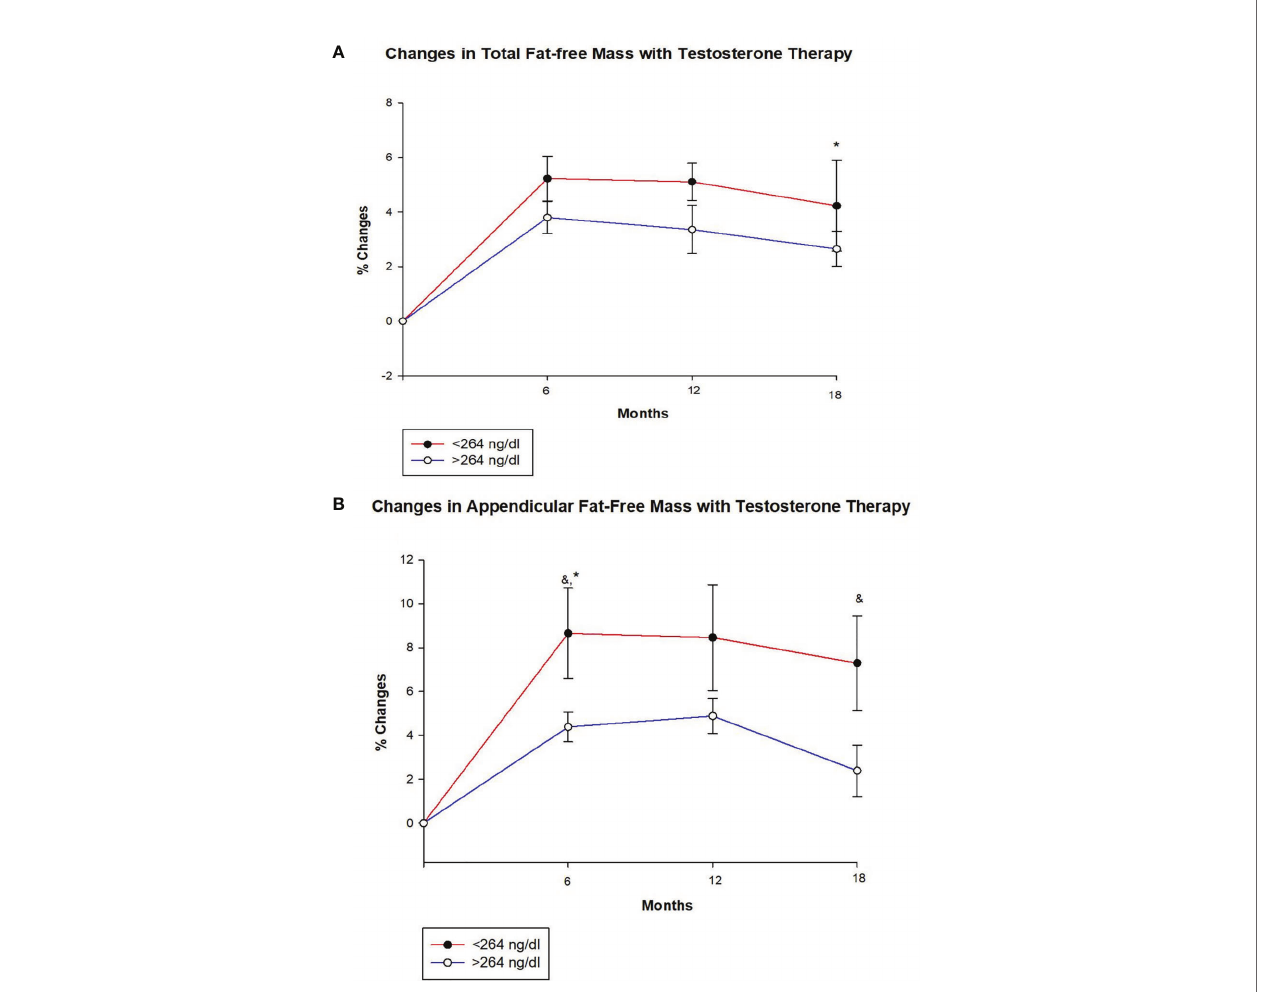
FIGURE 1 | Changes (%) in total and appendicular fat free mass with testosterone (T) therapy according to baseline testosterone level. T < 264 ng/dL (red line), T ≥ 264 ng/dL (blue line). & Unadjusted P < 0.05, *Adjusted P value < 0.05, adjusted for age and body mass index. (A) Total FFM increased in both groups at 6, 12 and 18 months, but the increase at 18 months was greater for those with T < 264 ng/dL compared to those with T ≥ 264 ng/dL (adjusted p = 0.047). (B) Appendicular FFM increased uniformly in both groups at 6, 12 and 18 months. However, the increase was greater in group with T < 264 ng/dL at 6 months (unadjusted p = 0.033 and adjusted p = 0.034) and 18 months (unadjusted p = 0.043) compared to those with T ≥ 264